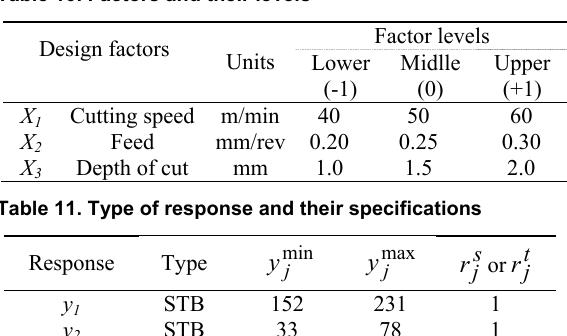
Table 10. Factors and their levels